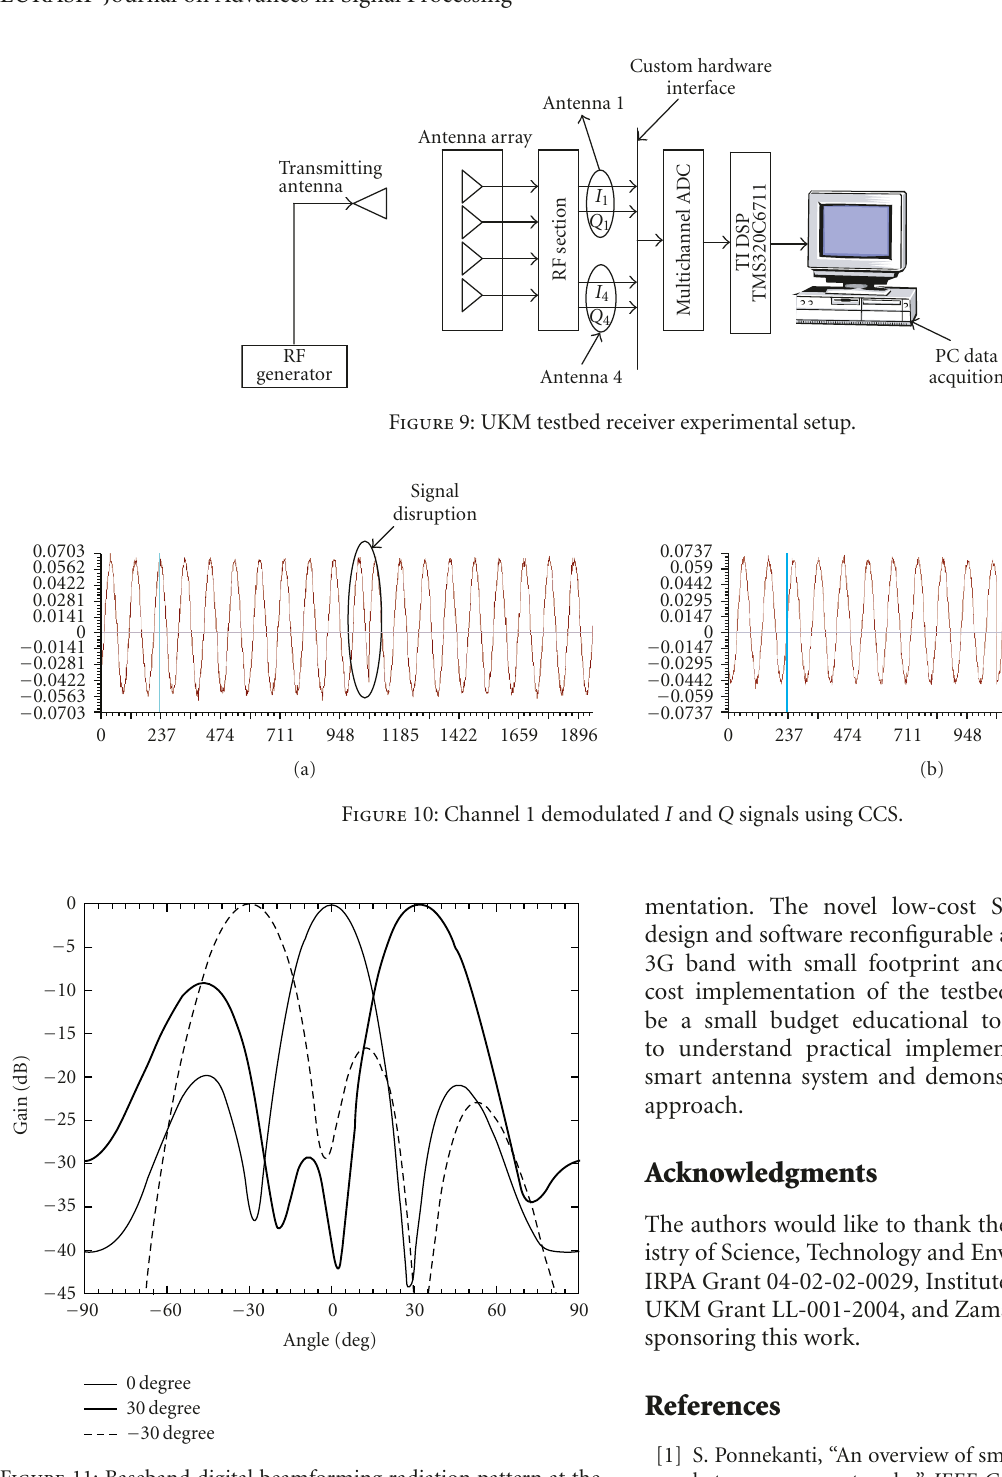
Figure 11: Baseband digital beamforming radiation pattern at the angles − 30 ◦ , 0 ◦ , and 30 ◦